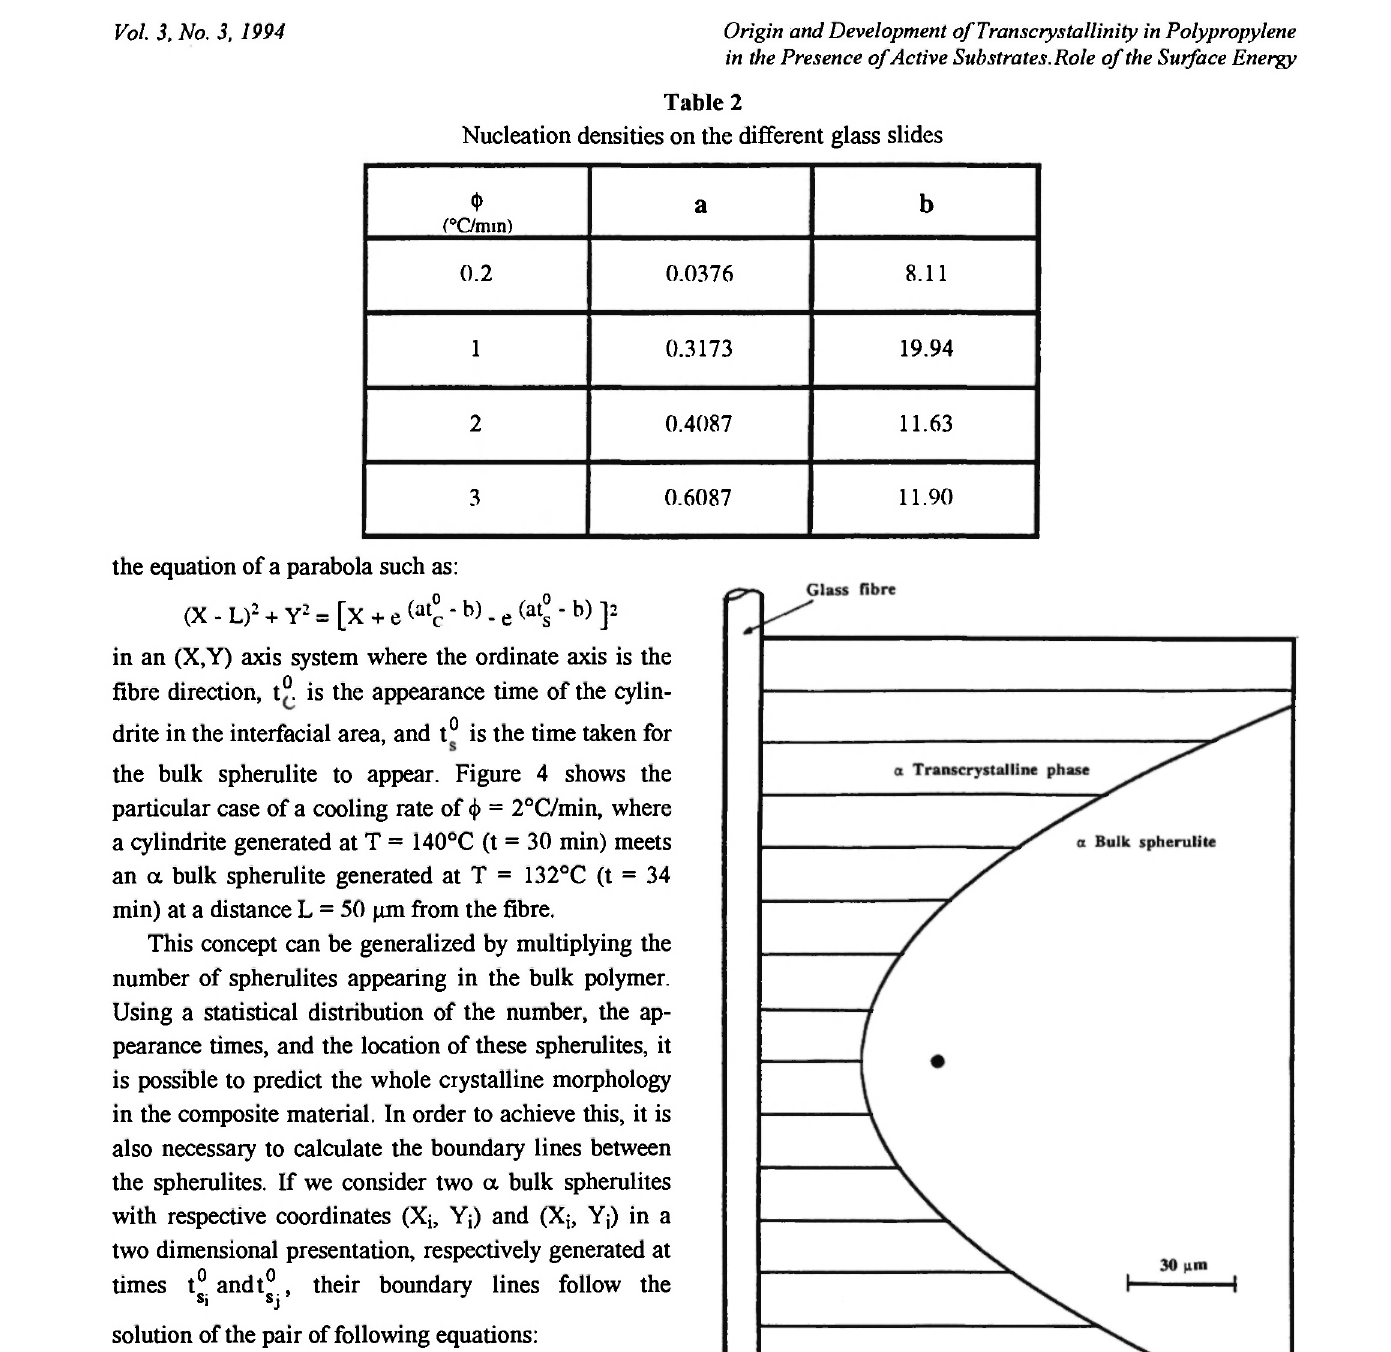
Fig. 4: Simulation of the boundary line between an α bulk spherulite and an α transcrystalline phase during a cooling at